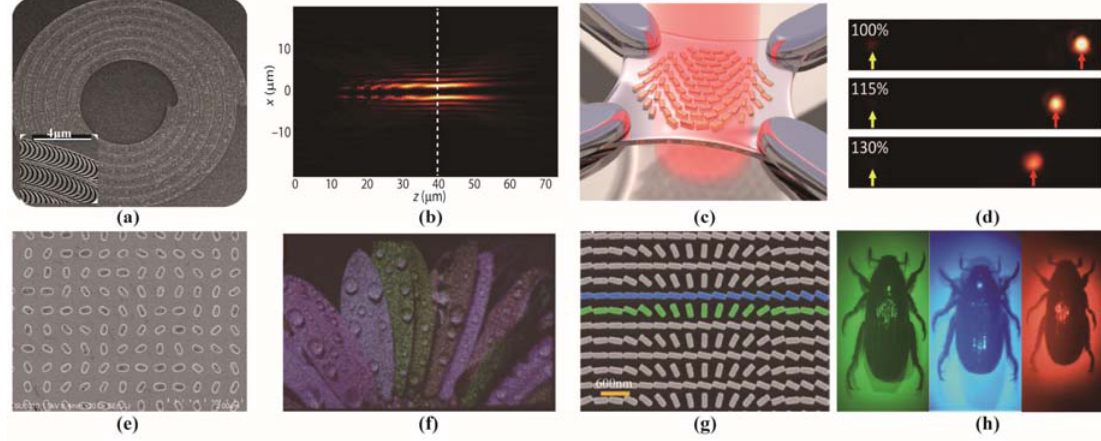
Figure 4. Different functional metasurfaces with chiral distribution of anisotropic unit cells. ( a ) SEM photo of metasurface with spirally distributed catenary structure for Bessel beam generation; ( b ) Electric field of the generated Bessel beam; ( c ) Stretchable metasurface with active focus length based on the chiral distribution of metallic nano rods; ( d ) The focus position of the metasurface with different stretch ratios; ( e ) Metasurface to generate a hologram with chirally-distributed slits; ( f ) The whole color hologram photo produced by the metasurface in ( e ); ( g ) Planar lens based on metamaterial with chirally arranged dielectric posts; ( h ) Multiple images of beetle Chrysina gloriosa using the metasurface in ( g ). ( a , b ) are reproduced with permission [94]; ( c , d ) are reproduced with permission [95]. Copyright American Chemical Society, 2016; ( e , f ) are reproduced with permission [97].